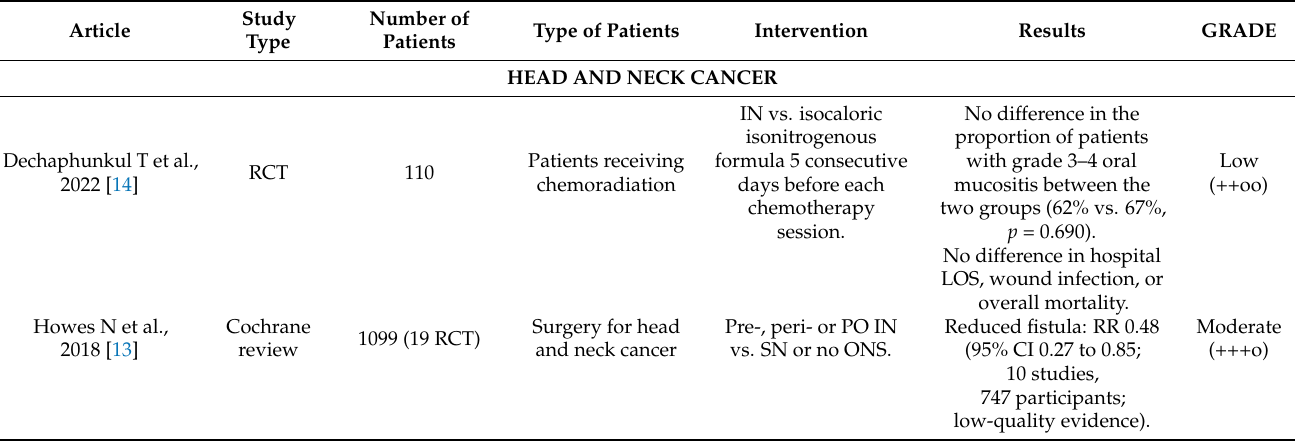
Table 3. Summary of the evidence obtained based on the search strategy and selection of articles with evidence rating using GRADEpro for head and neck surgery. IN: immunonutrition; SN: standard nutrition; ONS: oral nutrition supplement; PO: postoperative; LOS: length of